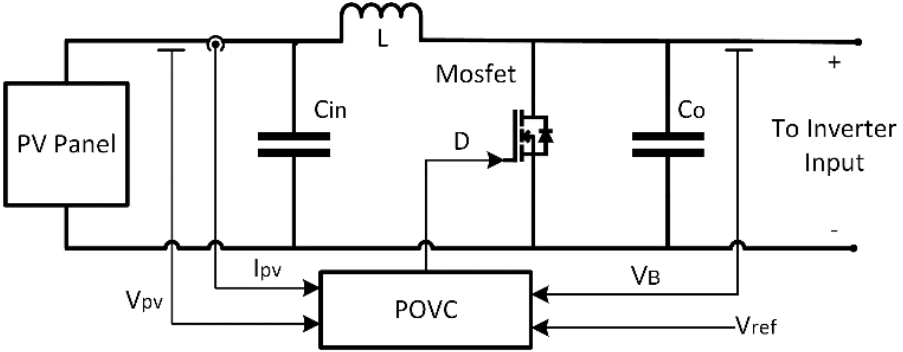
Figure 3. Boost DC-DC converter with POVC.